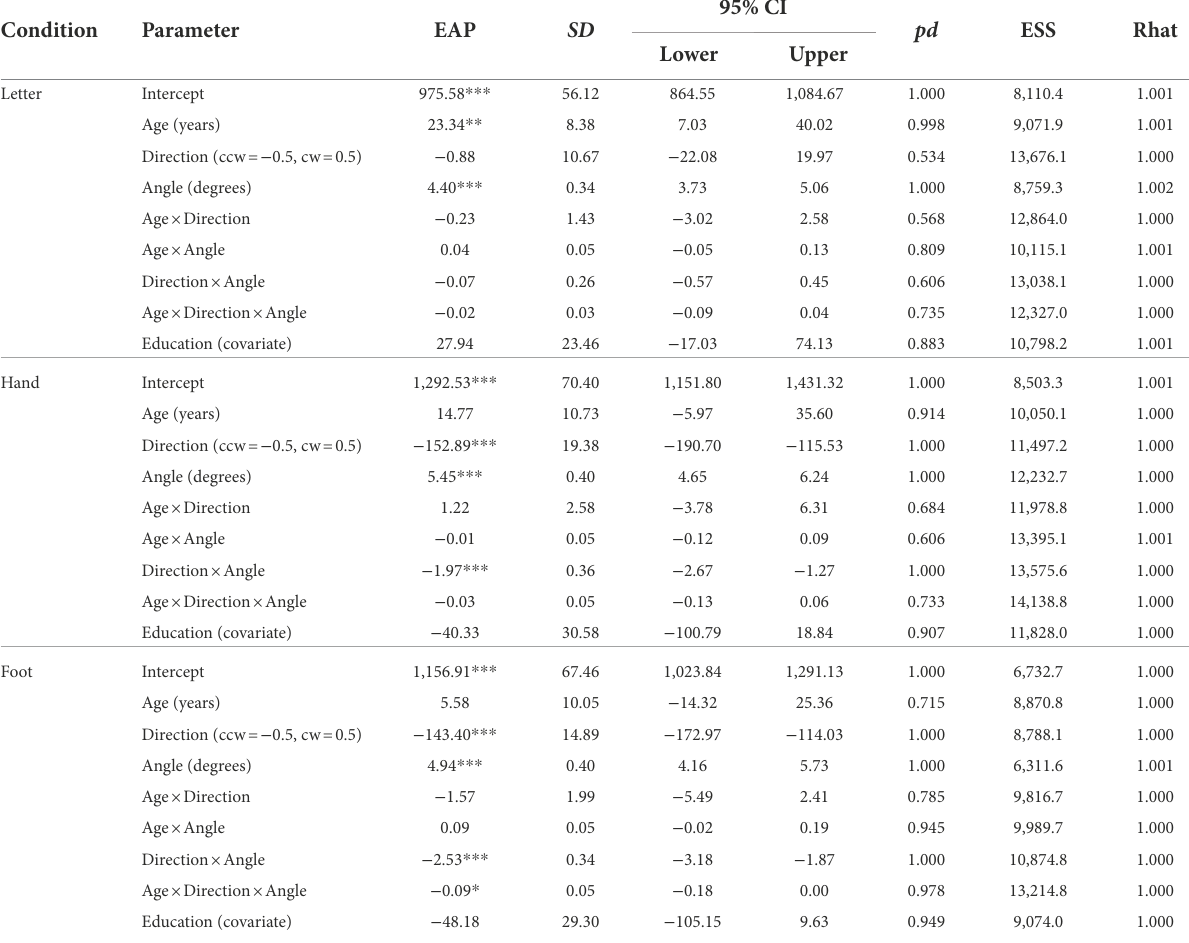
TABLE 2 Parameter estimates for comparison of the mental rotation Δ RT within older groups ( n =